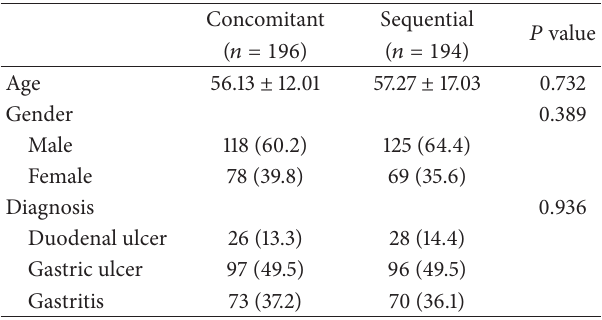
Table 1: Characteristics of patients 𝑛 (%).